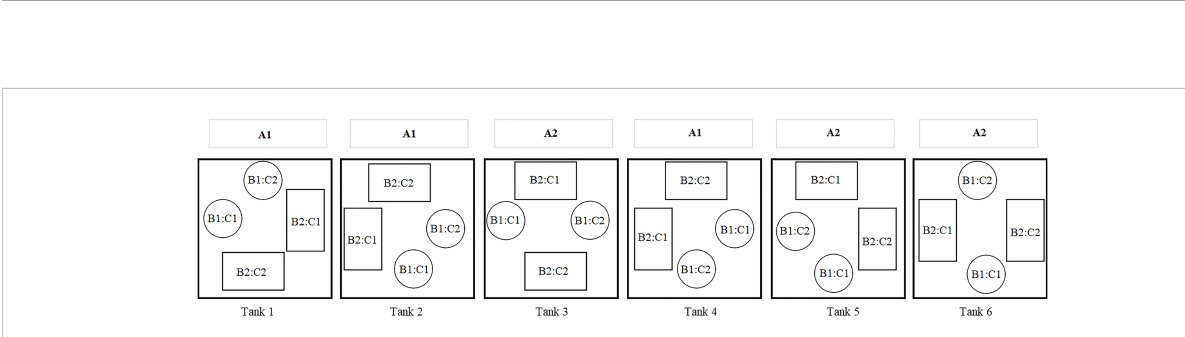
FIGURE 2 Experimental design during the trials where (A) is either natural (A1) or arti fi cial (A2) substrate; (B) is moderate 0.1 m s -1 (B1) or elevated 0.2 m s -1 (B2) water velocity and (C) is a spraying technique with (C1) or without (C2) binder. Both levels of each factor are distributed randomly amongst the 6 tanks and are represented in each block, n =